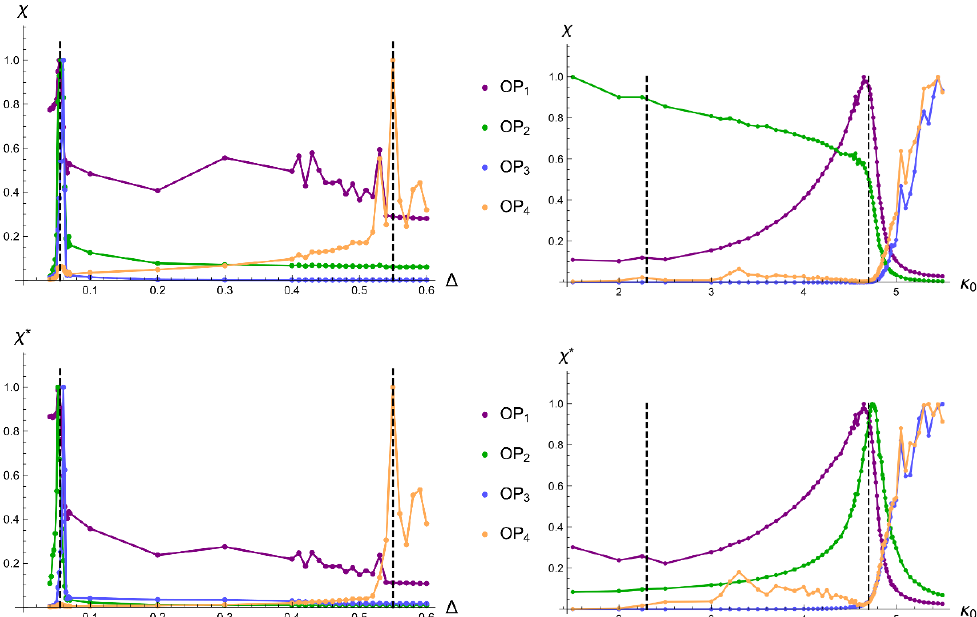
JHEP06(2018)111 Figure 13 . Susceptibilities (cid:31) (top plots) and (cid:31) (cid:3) (bottom plots) of the order parameters OP 1 , . . . , OP 4 , de(cid:12)ned in eqs. (4.5) and (4.6), respectively, in CDT with toroidal spatial topology ((cid:6) = T 3 ) and (cid:22) N = 160000, t tot = 4. The left plots show the susceptibilities as a function of (cid:1) for (cid:12)xed (4 ; 1) (cid:20) 0 = 1 : 5 and the right plot shows the susceptibilities as a function of (cid:20) 0 for (cid:12)xed (cid:1) = 0 : 4, which corresponds to the order parameters shown in (cid:12)gure 12. The susceptibilities were rescaled to (cid:12)t into a single plot. The positions of the B (cid:0) C b and C b (cid:0) C phase transitions on the left plot and the C b (cid:0) C and C (cid:0) A phase transition on the right plot are signaled by peaks in the susceptibilities, which is marked by the same dashed lines as in (cid:12)gure 12. Figure 14 . Phase diagram of CDT with toroidal spatial topology from (cid:12)gure 10 together with the phase transition lines (thick lines) of CDT with spherical spatial topology from (cid:12)gure 3. { 16